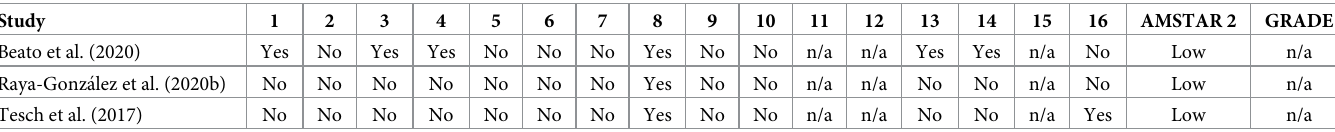
Table 3. Overall results of the AMSTAR 2 and GRADE recommendations for narrative reviews. Study